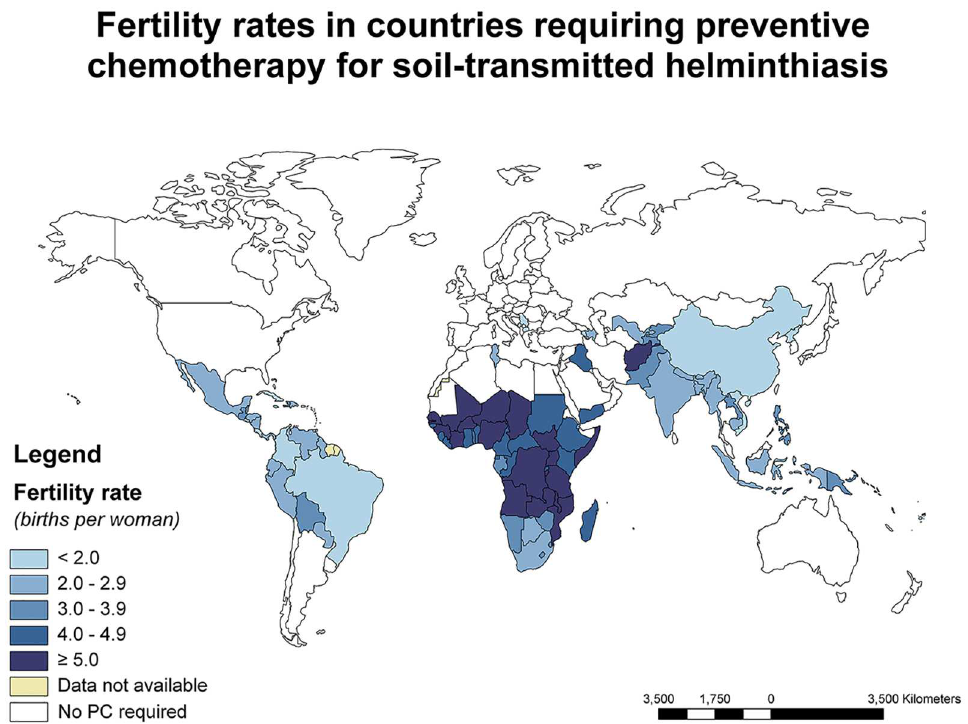
Fig 1. World map showing fertility rates (blue shading) among countries determined to be in need of PC for STHs according to WHO guidelines: Fertility data are taken from the World Development Indicators Databank (World Bank, 2013) and the World Statistics Pocketbook (United Nations Statistics Division, 2010–2015). Data on the need for PC in childrenfor STH infectionare taken from the WHO Preventive Chemotherapy Databank(World Health Organization, 2013). Fertility rates (in parentheses) for endemicregions that could not be displayedare: Cape Verde (2.3), Comoros (4.6), French Polynesia(2.1), Kiribati (3.8), Marshall Islands (4.1), Mauritius (1.4), Micronesia(3.3), Nauru (4.3), Sao Tome and Principe(4.6), Tonga (3.8), and Tuvalu